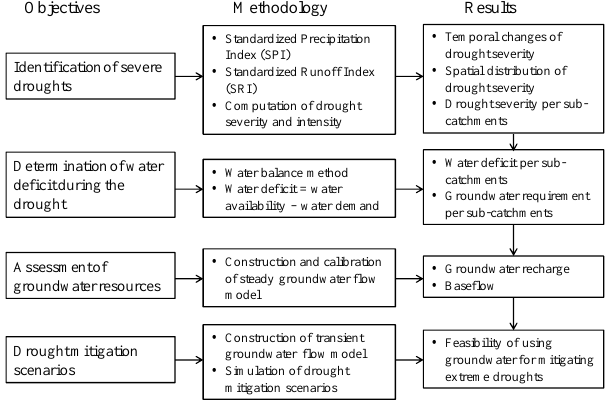
Figure 2. Research